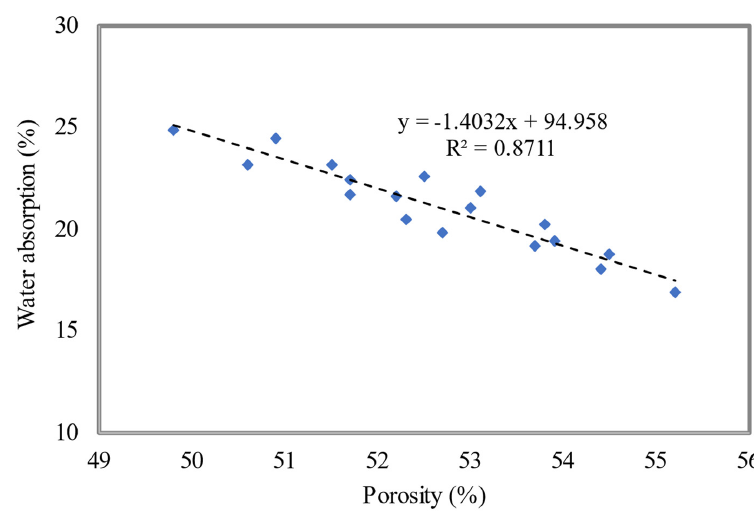
Figure 21. Relationship between water absorption and porosity.